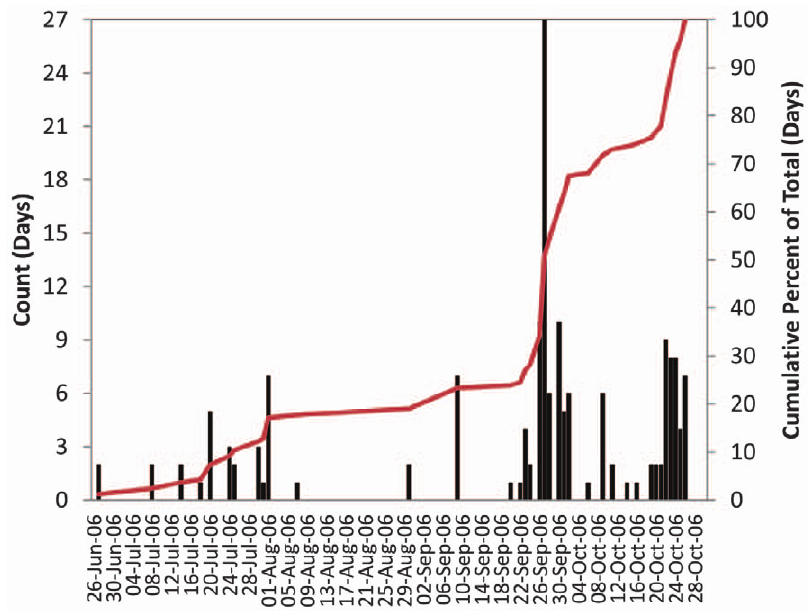
Figure 2. Histogram and Cumulative Percentage Plots for Acoustic Tag Detections. Frequency (left vertical axis) and cumulative percentage (right vertical axis) of detection-days by date for 37 sturgeon detected among 20 hydroacoustic receivers used in this analysis.